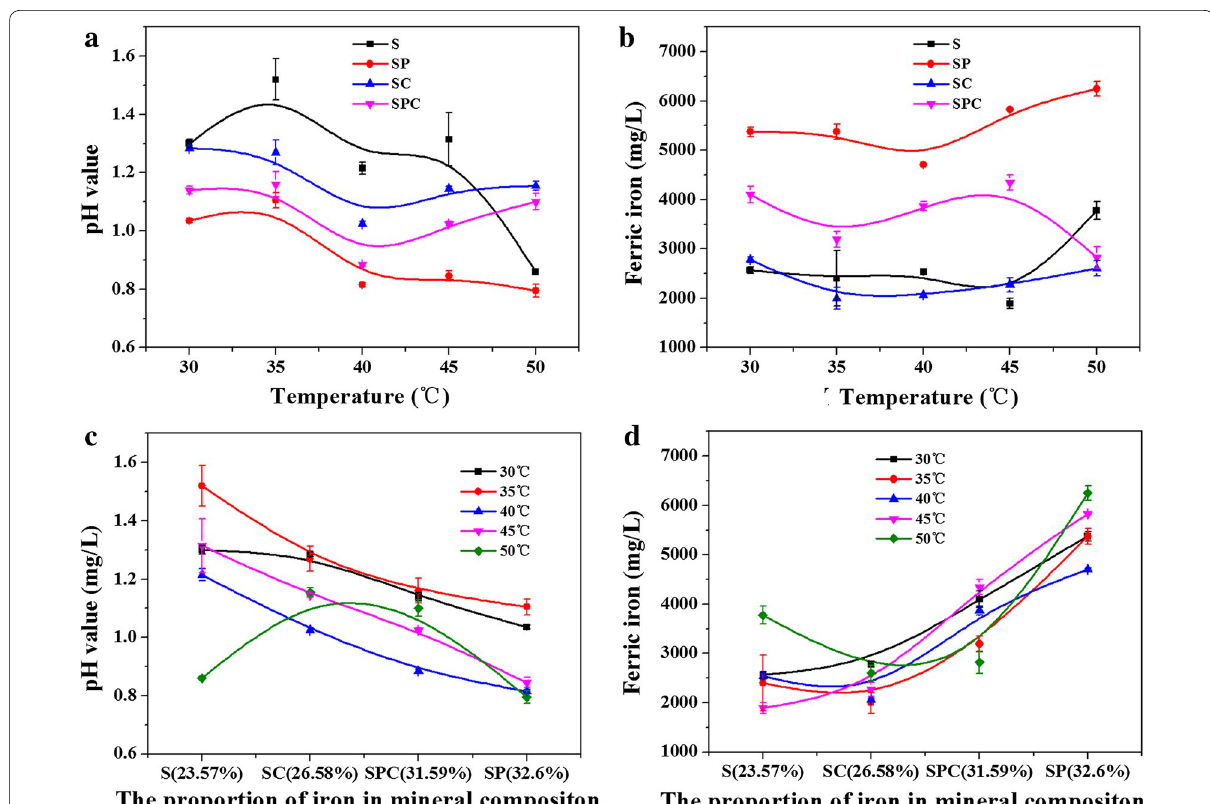
Fig. 2 pH value and the concentration of ferric iron on day 30 under different temperature ( a pH; b ferric iron) and different mineral composition ( c pH; d ferric